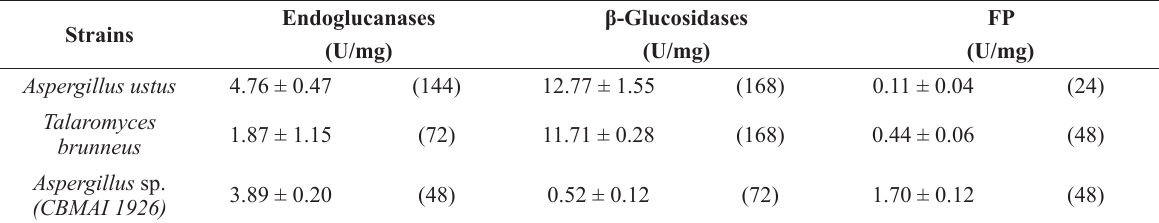
Mean and standard deviation of the maximum specific activity of endoglucanases, β-glucosidases and FP during submerged cultivation of fungal strains isolated from Catão cave (numbers in parenthesis corresponds to the cultivation time in